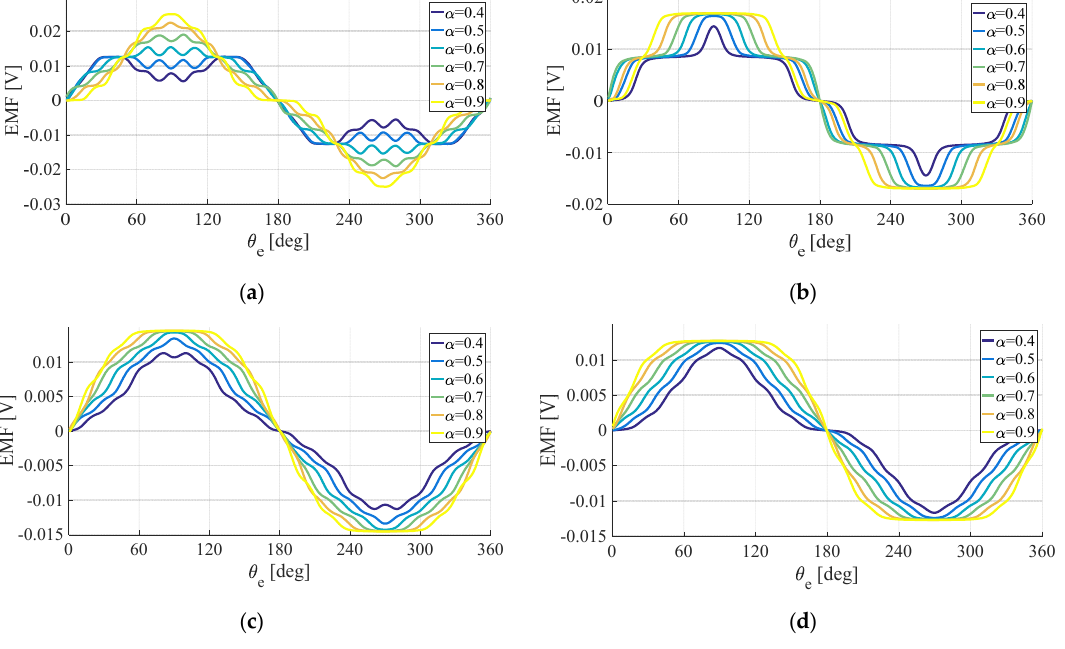
Figure 4. Phase back-emf of 8 poles ( a ), 12 poles ( b ), 14 poles ( c ) and 16 poles ( d ) rotors.